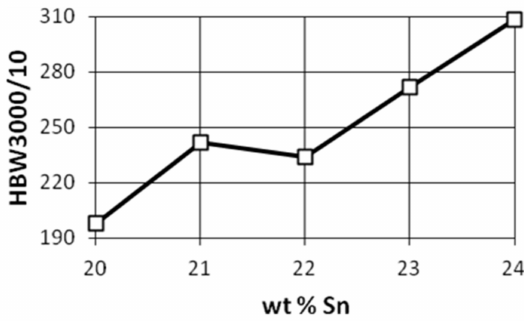
Figure 6. The hardness of high-tin bronzes versus tin content [8].